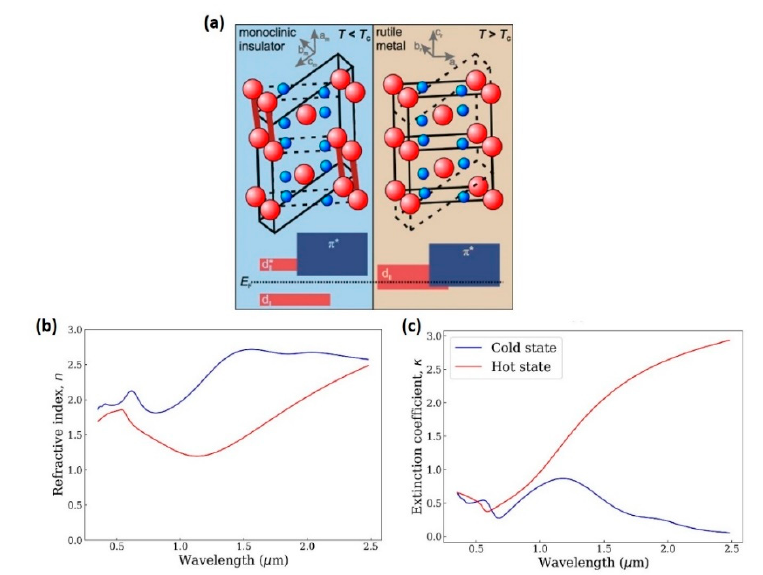
Figure 2. Transition metal oxide phase change material VO 2 . ( a ) Comparison of monoclinic and rutile crystallographic structures; the unit cells are indicated by solid lines. Vanadium atoms are represented by red balls; oxygen atoms are blue. The electronic band structure near the Fermi level is given at the bottom. ( b ) Refractive index and ( c ) extinction coefficient of VO 2 in the cold and hot states showing a large change in refractive index and extinction coefficient with the temperature. (( a ) reproduced with permission [51]; ( b , c ) reproduced with permission [52]).